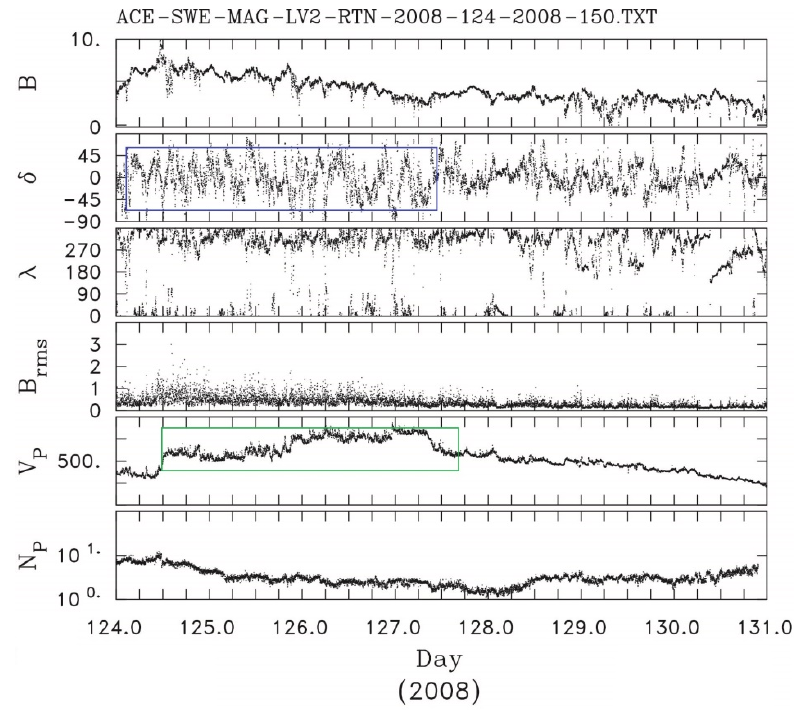
Figure 9. Weekly magnetic field and solar wind fluctuations recorded by ACE from 124.0 th day to 131.0 th day in 2008 (3 May to 9 May 2008). The panels, from top the bottom, display the magnetic field magnitude B , the polar coordinates of the field δ and λ , the uncertainty B rms , solar wind velocity V p and the density of the proton plasma N p .